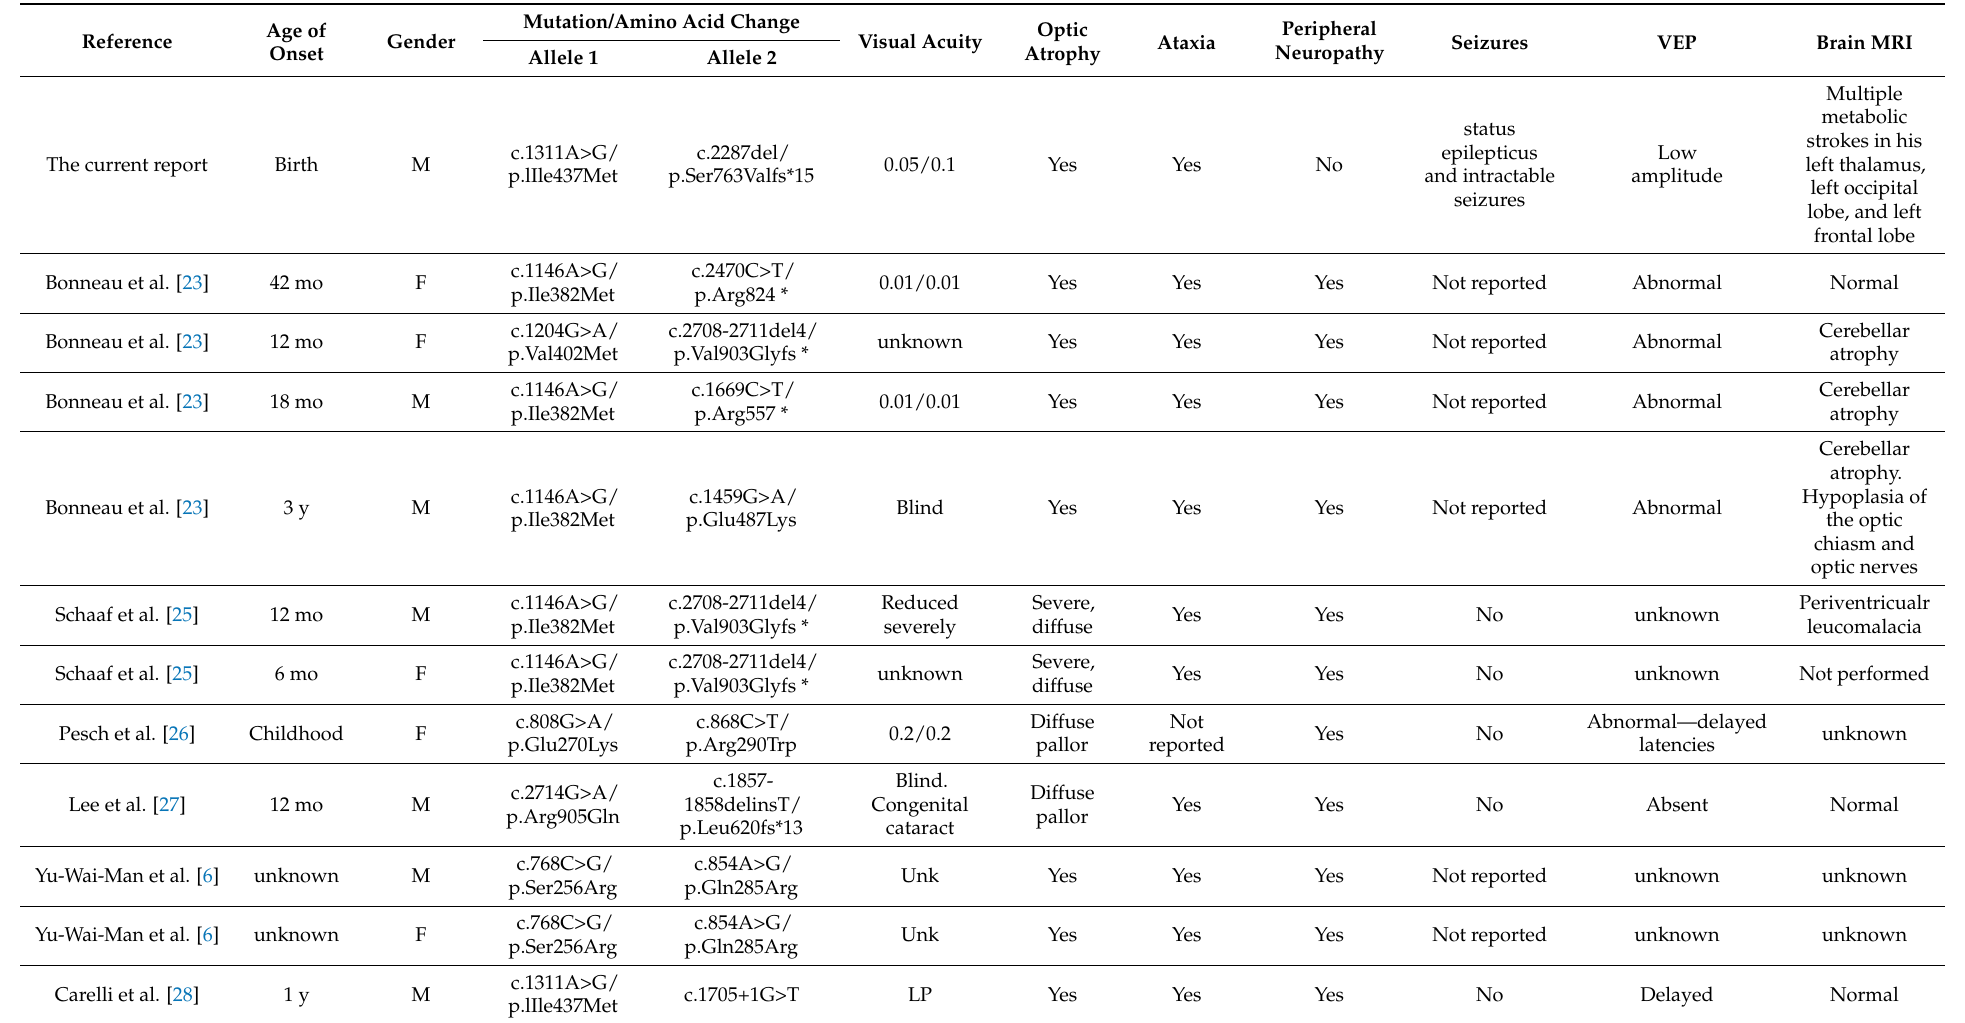
Table 1. Summary of previous cases of patients with compound heterozygous optic atrophy 1 ( OPA1 ) pathogenic variants mo—months; y—years; M—male;